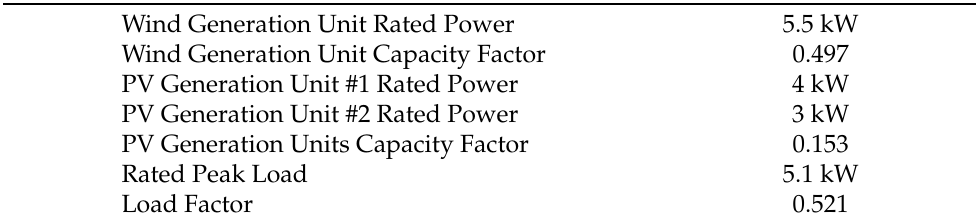
Table 1. System ratings and their corresponding capacity/load